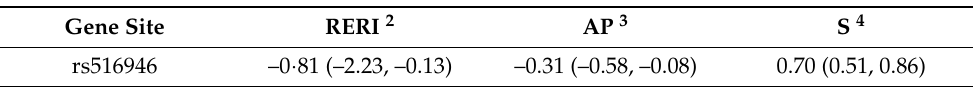
Table 4. Additive interaction results (95% CI) for dietary iron intake and the SNP rs516946 among the male participants 1 .